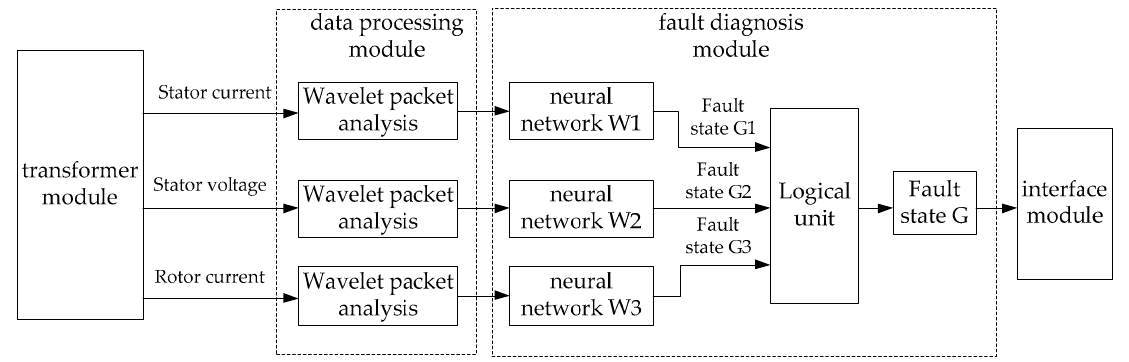
Figure 13. Symmetrical loss of excitation fault diagnosis system for the asynchronized high-voltage generator.